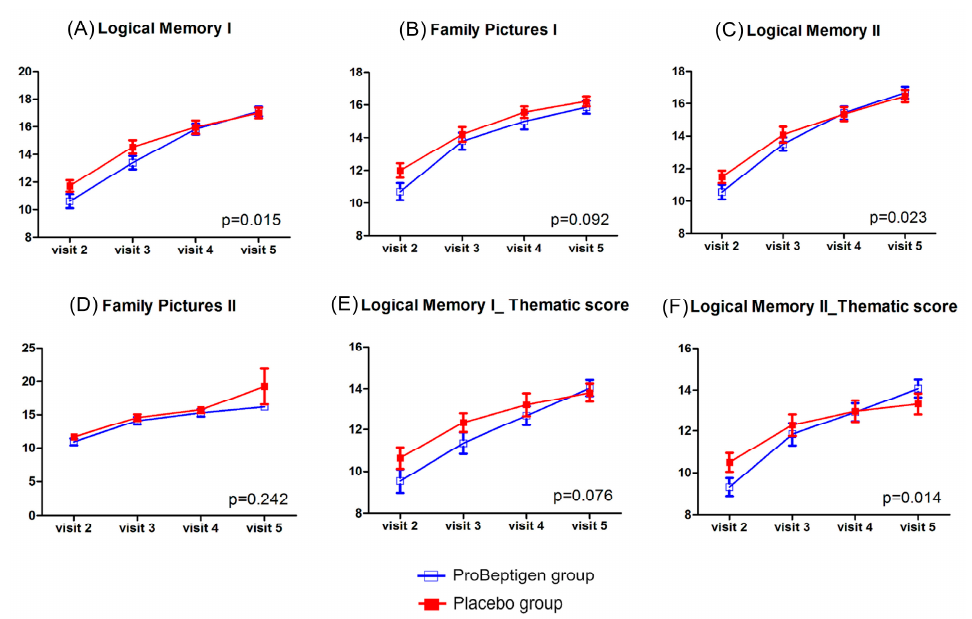
Figure 3. Results from Logical Memory and Family Pictures subtests of the Wechsler Memory Scale-3rd edition. ( A ) Logical Memory I, ( B ) Family Pictures I, ( C ) Logical Memory II, ( D ) Family Pictures II,